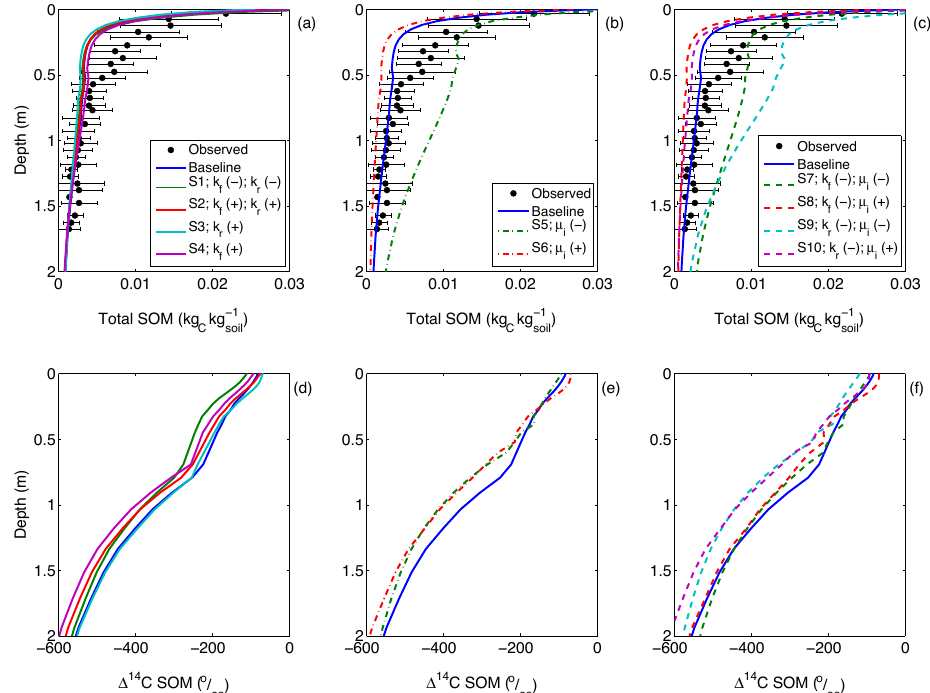
Figure 6. Total SOM content (top row) and 1 14 C of total SOM (bottom row) at end of 10000-year simulation for the ten sensitivity scenarios ( a and d : S1–S4; b and e : S5–S6; c and f : S7–S10) that varied combinations of k f , k r , and µ i (Table